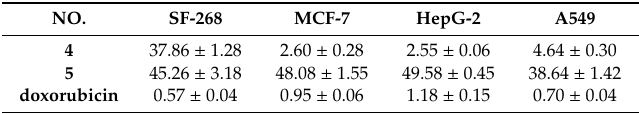
Table 4. IC 50 ( µ M) of compounds 4 – 5 against four tumor cell